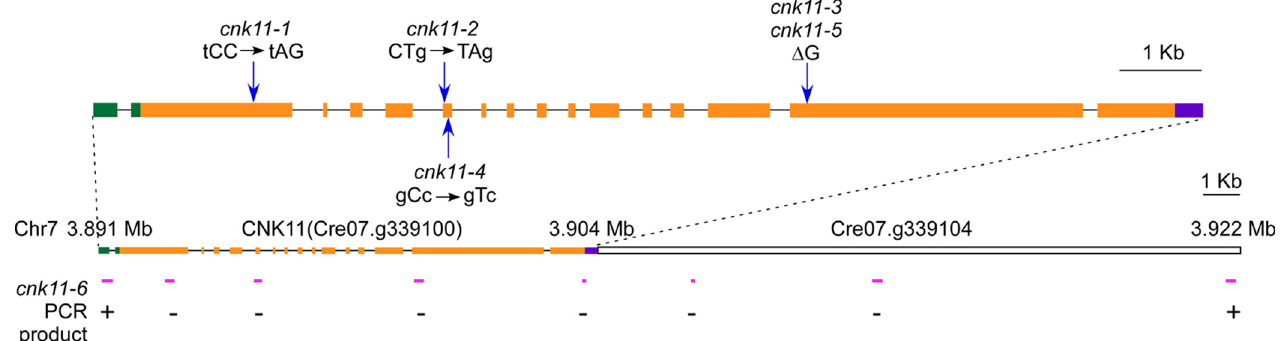
Fig 2. Gene structure of CNK11 and its position on chromosome 7. Blue arrows indicate the relative positions of changes found in individual mutants. Green boxes, 5 ’ UTR; black solid lines, introns; orange boxes, exons; purple box, 3 ’ UTR. Magenta solid lines, relative positions of PCR products along CNK11 and its neighboring gene Cre07 . g339104 in cnk11-6 . +, PCR products amplified in both wild-type and cnk11-6 ;-, PCR products amplified in wild-type but not in cnk11-6